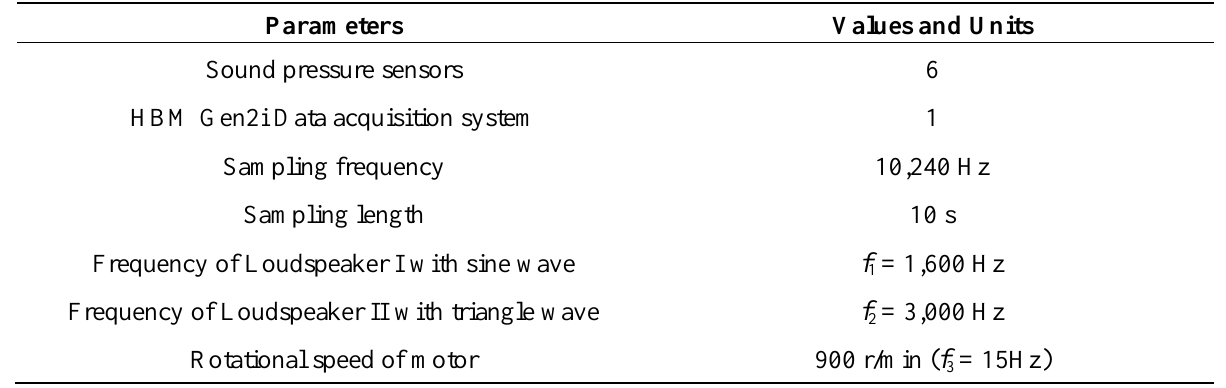
Table 3. The testing parameters of the measuring system.